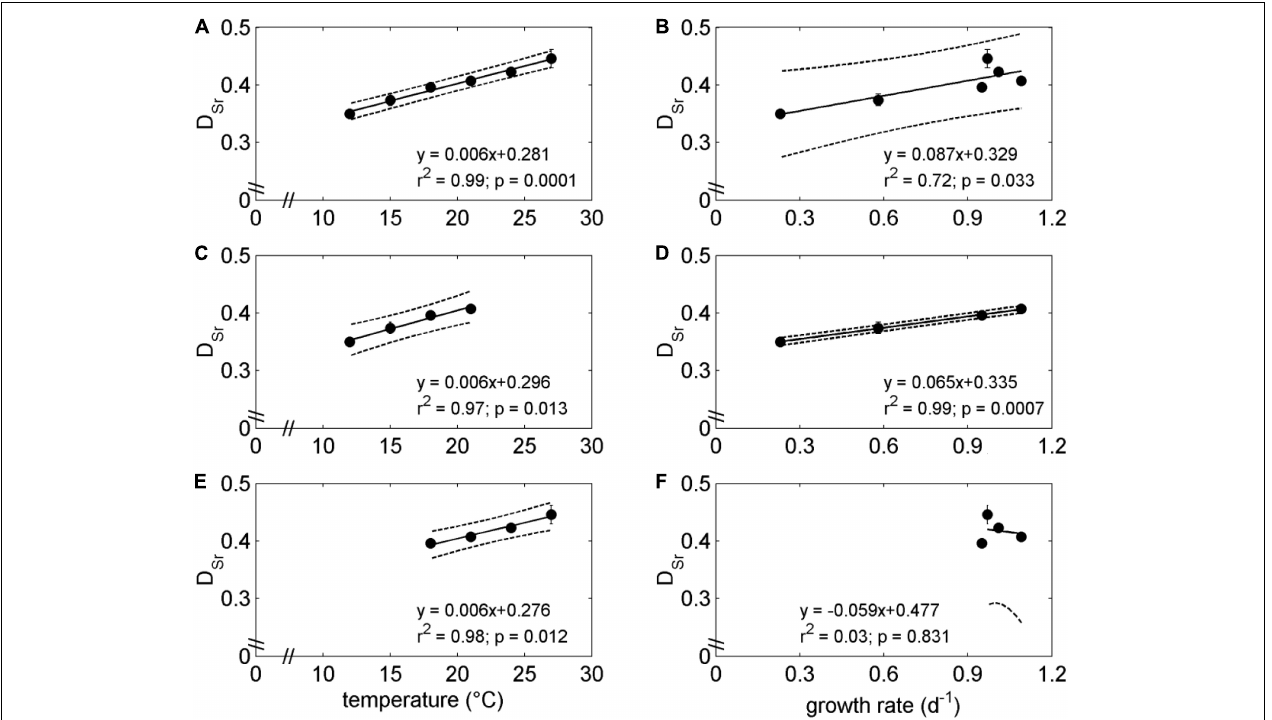
FIGURE 2 | Regression analysis investigating the relation of D Sr with temperature (A,C,E) and population growth rate (B,D,F) . (B,D,F) represent data points at temperatures from 12 to 27, 12 to 21, and 18 to 27 ◦ C,